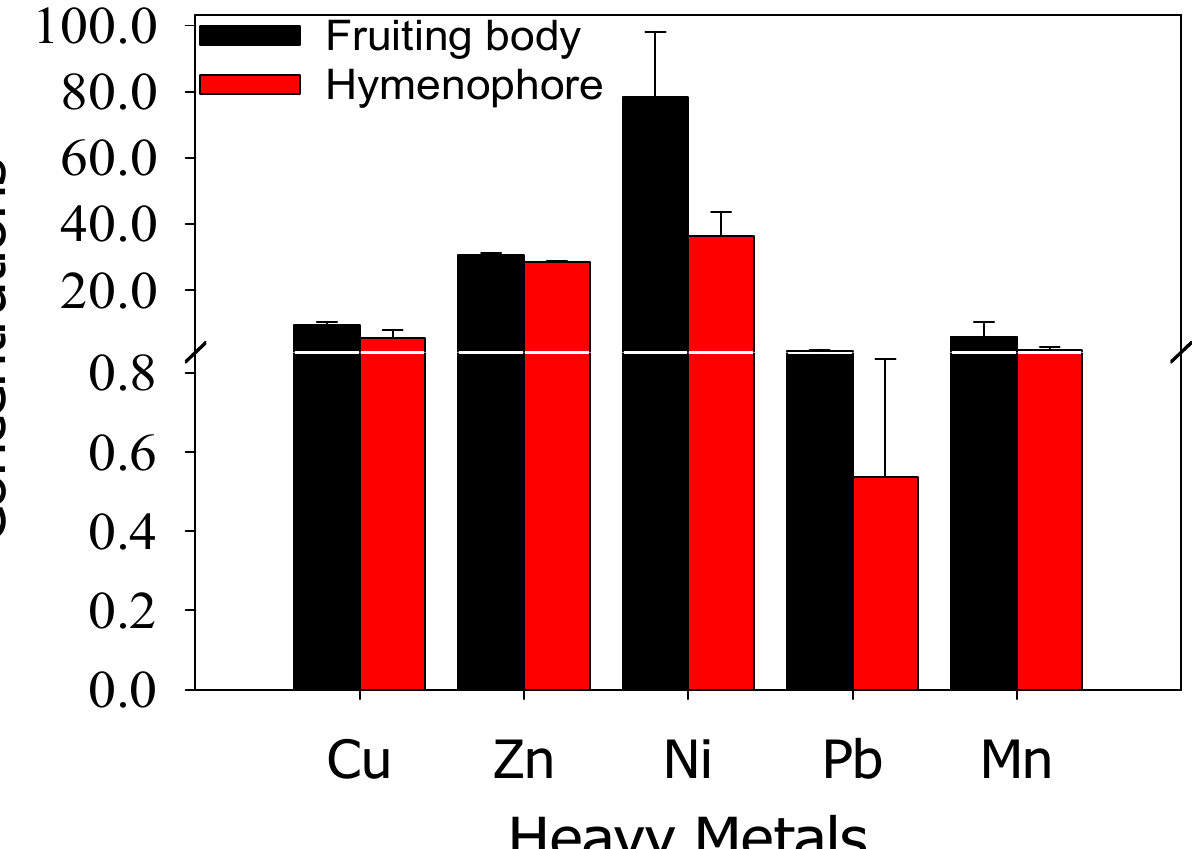
Figure 3. Mean heavy metals concentration (mg/kg) in M. galilaea (fruiting body and Hymenophore). Previously, higher concentrations of 190 mg/kg [37], 240 mg/kg, and 580 mg/kg [38], were reported in the fruiting bodies (FB). As shown in Table 2, the hymenophore (H) of Table 3. Translocation factor from FB to H for selected heavy metals. M. galilaea have a lower Zn concentration in FB with the c/s value of 1.0–1.1. These results corroborate those reported previously [39]. However, the results may vary depending on the species, soil, and environmental conditions. For instance, a higher c/s ratio (c/s = 4.6) has been reported in the fruiting body of Boletus edulis studied in China